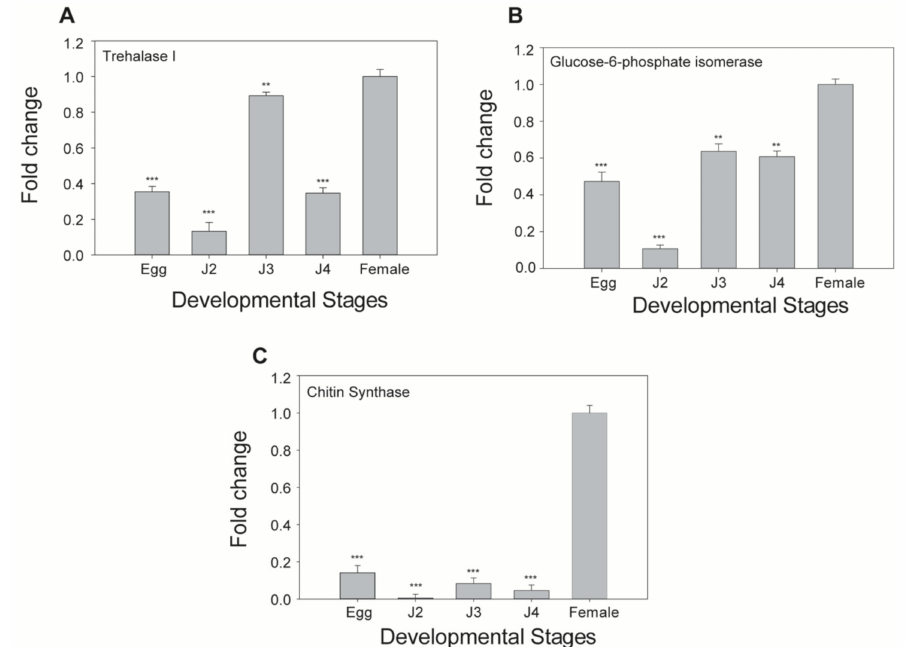
Figure 3. mRNA expression analysis by qRT-PCR at di ff erent developmental stages of M . incognita . Gene expression levels were normalized with β -actin and shown as fold changes in expression compared to the female stage. The results of fold change values were converted using 2 − ∆∆ Ct values from three genes. ( A ) Trehalase 1 (Minc3s02136g28499), ( B ) GPI (Minc3s00787g17359), and ( C ) CS (Minc3s00218g07846). Each bar represents the mean ± standard deviation (SD) of three independent experiments with three technical replicates. Statistical analyses ( t -test) were conducted using SigmaPlot 12.5. For t -test analysis, female stage values were used to compare to the values of genes in other stages. Asterisk indicates significant di ff erences compared with wild-type (** p < 0.01, *** p <